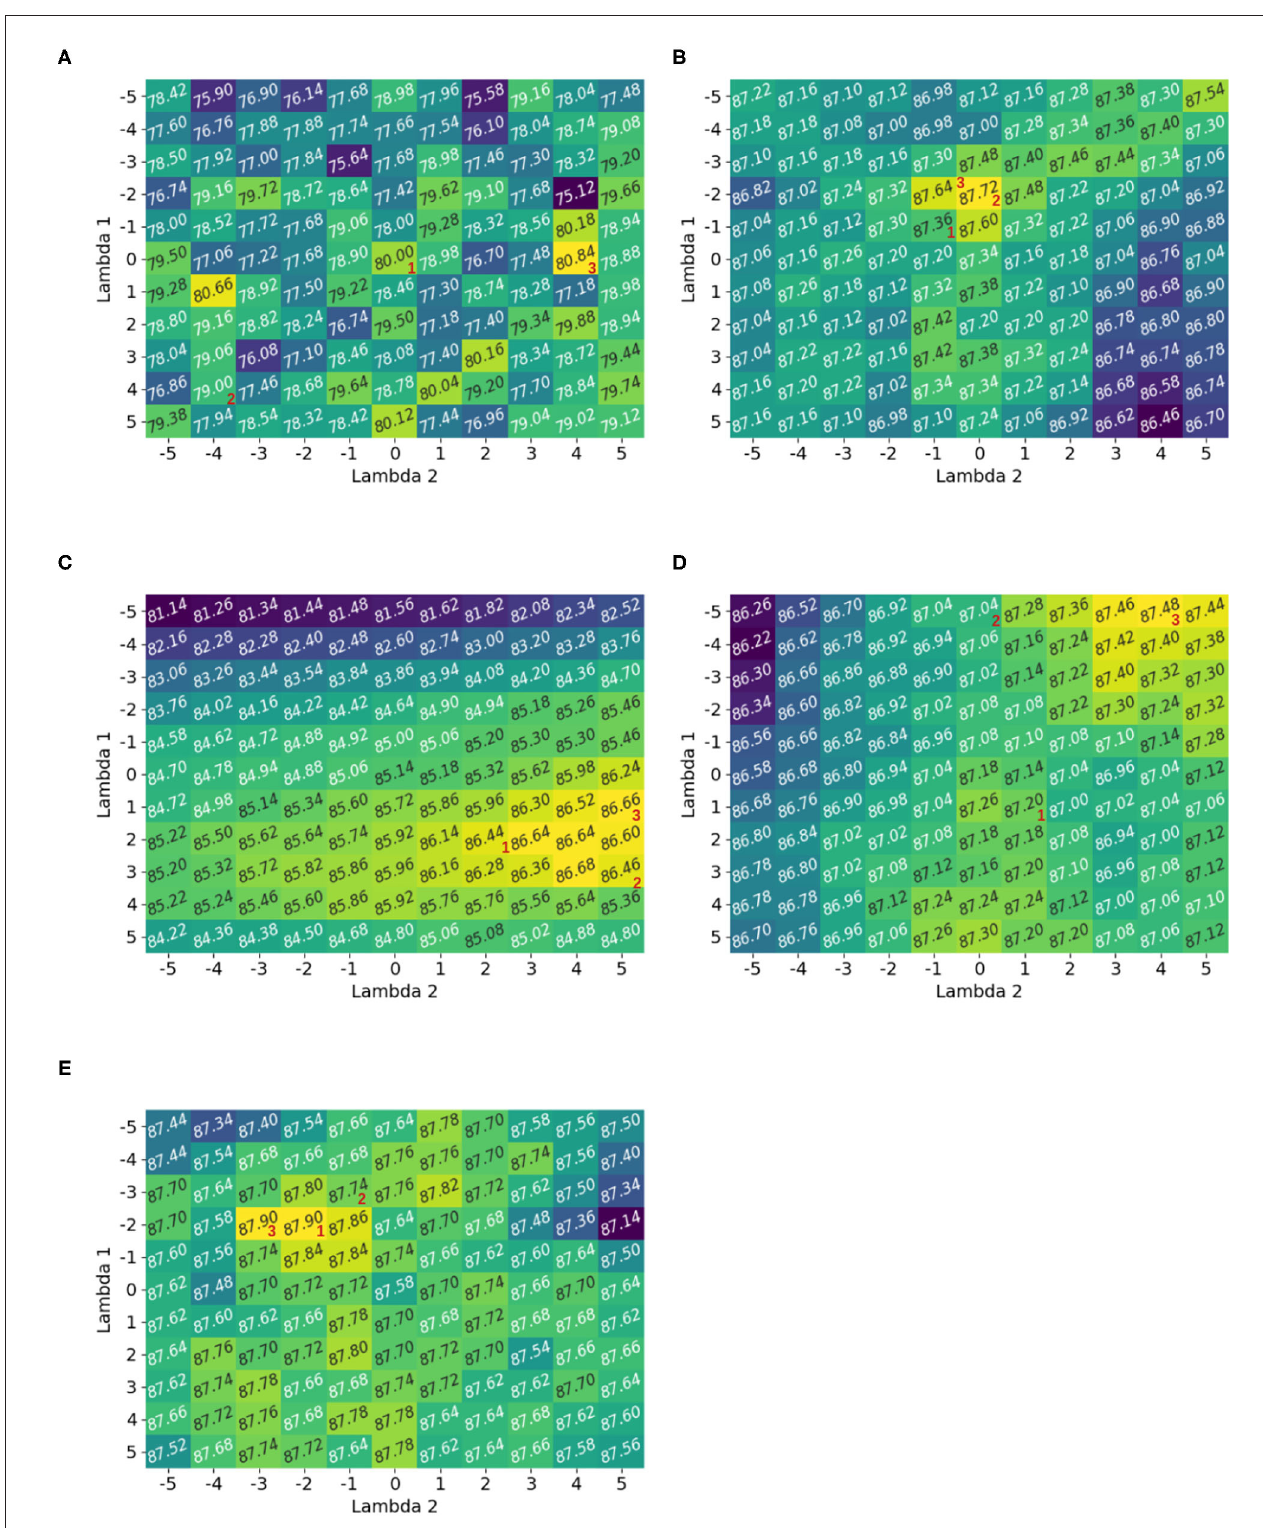
FIGURE 2 | Accuracy heatmaps generated by Algorithm 1 for a random dataset. The numbers 1, 2, and 3 correspond to the optimal solution for the spherical , diagonal , and full optimization. If there are multiple solutions then only one possibility is shown. It was observed that the optimal parameter choice for the Box-Cox transformation depends on the classifier. The heatmaps showed multiple local maxima and full optimization led to the best optimization result. (A) Linear classifier, (B) KNN classifier, (C) Bayesian classifier, (D) SVC classifier, and (E) NN classifier.